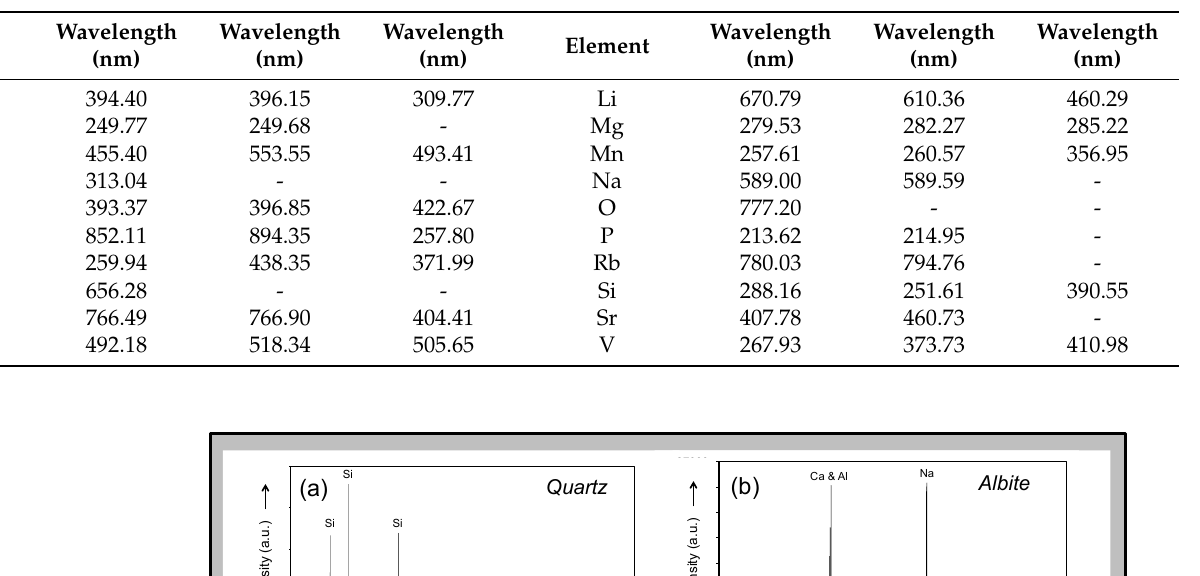
Table 1. Emission lines for most common elements identified in pegmatite minerals from the Carolina Lithium Project prospect in Gaston County, North Carolina (USA).